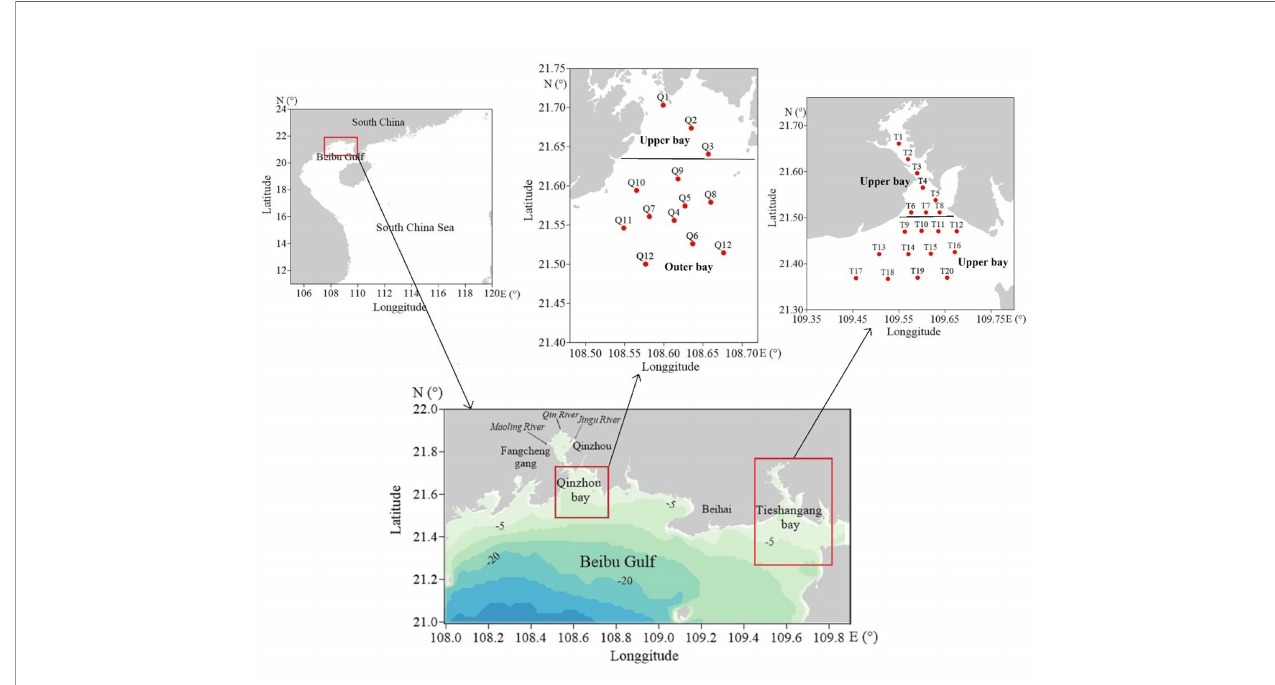
FIGURE 1 | Map of Beibu Gulf and sampling stations. The red boxes are the sampling areas, including Qinzhou Bay and Tieshangang Bay in the Beibu